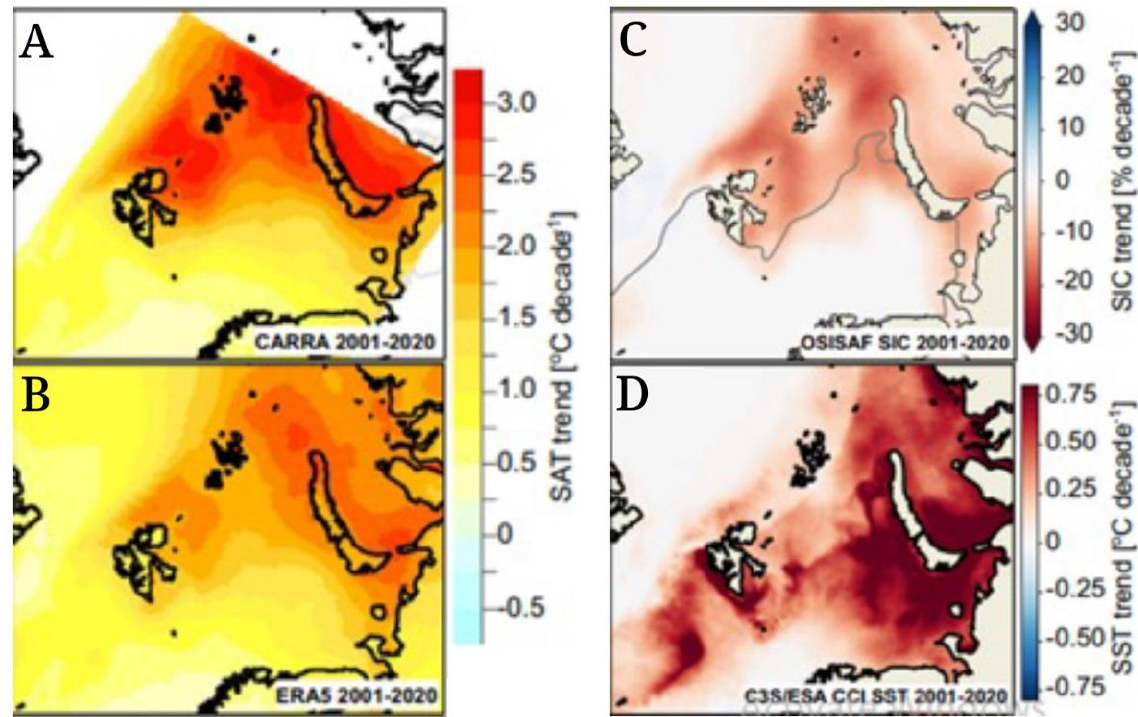
Figure 6. The spatial pattern of changes in surface air temperature, sea ice, and sea surface temper- ature (SST) trends in the Barents study area for 2001 – 2020. ( A , B ) Annual SAT trends (°C/decade) derived from CARRA and ERA5 reanalyses. ( C ) Annual trends in sea ice coverage (SIC) (%/decade) with mean 15% SIC (ice edge) contour line marked in grey. ( D ) presents the annual SST trends (°C/decade).